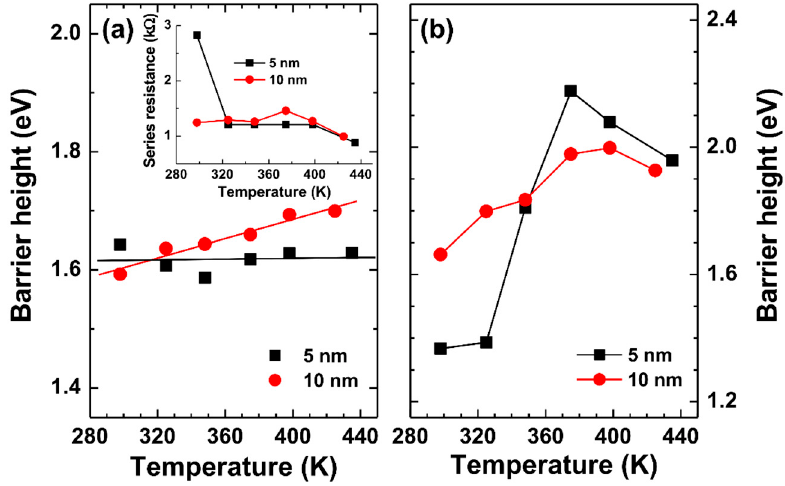
Figure 5. ( a ) Barrier heights obtained from thermionic emission (TE) component and ( b ) flat-band barrier heights. The inset in ( a ) shows the series resistances obtained from the